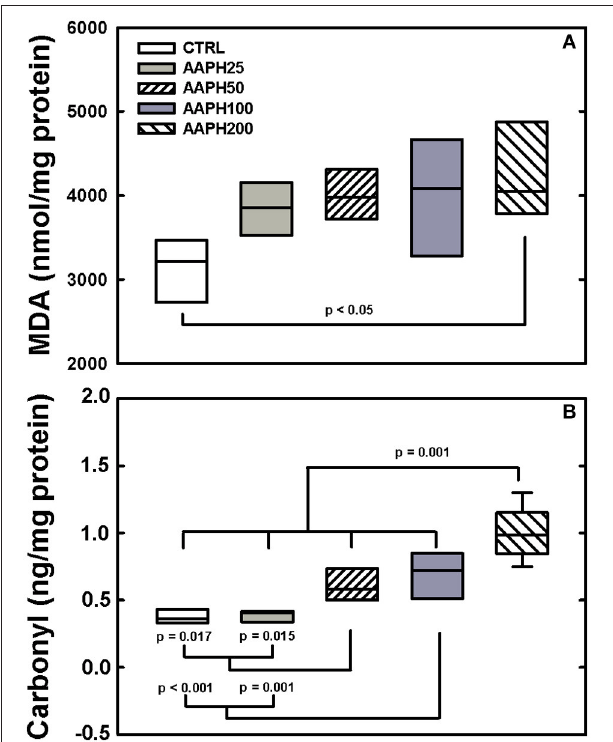
FIGURE 6 | Determination of oxidative damage. (A) Malondialdehyde (MDA). (B) Carbonyl groups. Animals exposed to saline solution (CTRL) or different amounts of 2,2 ′ -azobis (2-amidinopropane) dihydrochloride (AAPH25, 50, 100, and 200 mg/kg in saline solution). Panel (A) shows that AAPH200 presented higher values of MDA than CTRL animals. In panel (B) , AAPH200 carbonyl value was larger than in the other groups; AAPH50 and AAPH100 were greater than in CTRL and AAPH25 groups. Boxes show interquartile (25–75%) range, whiskers encompass 10–90% range, and horizontal lines represent median of 8 animals in each group. P -values are